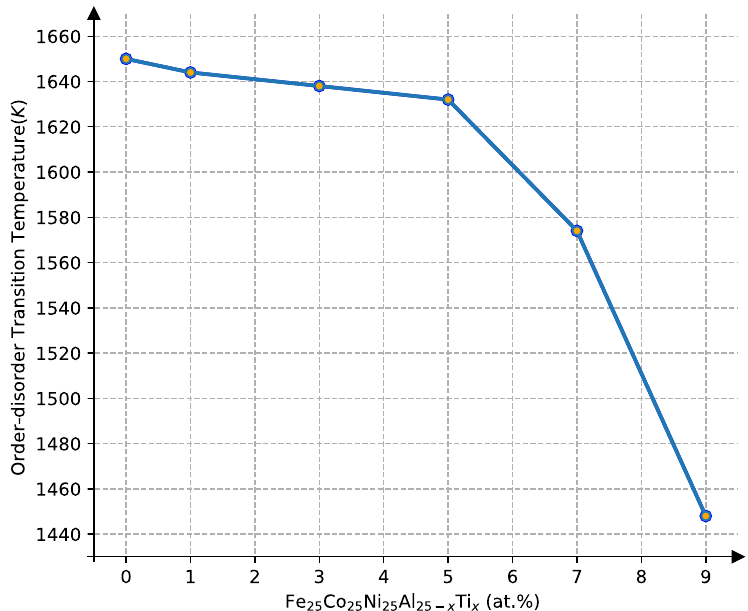
Figure 6. Order–disorder transition temperature as a function of Ti contents in FeCoNiAl 25 − x Ti x HEAs.